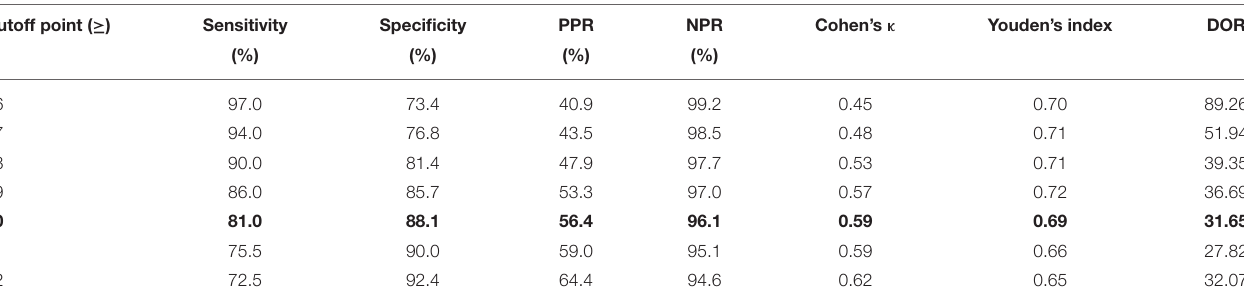
TABLE 3 | Cutoff points of C-IGDC based on the DSM-5 proposed diagnostic criteria of IGD ( N = 1,253). Cutoff point ( ≥